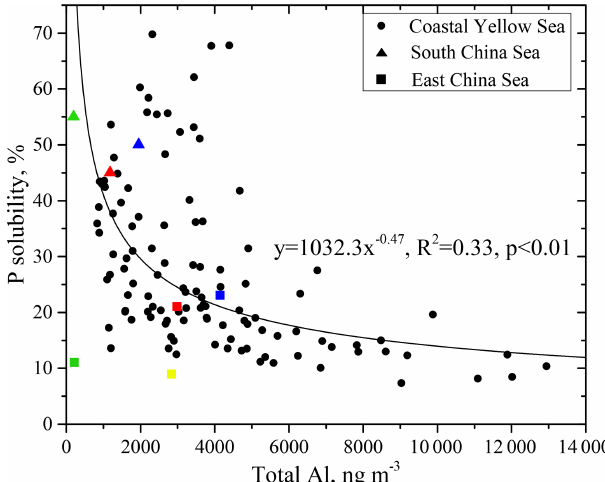
Figure 4. Relationships of P solubility against total Al. Data in the South China Sea are from Hsu et al. (2014) (triangles), and data in the East China Sea are from Guo et al. (2014) (squares). Different color symbols are used to highlight different observation periods. The green and red triangles represent the averages of observations in the South China Sea during cruises in February–March 2013 and June 2013, respectively; the blue triangles represent the ob- served values of the samples affected by biomass burning in the June cruise. The blue, green, yellow and red squares represent the averages of observations over Huaniao Island in the East China Sea during April, July–August and November–December 2010, and March 2011,